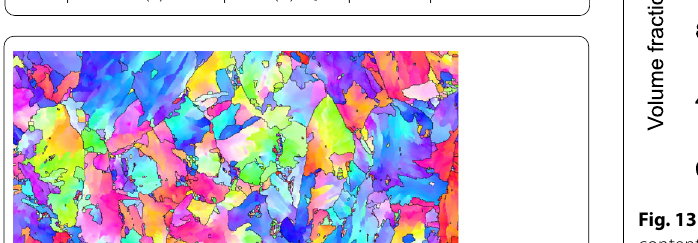
Fig. 10 EBSD result subjected to Final LePera etching conditions of 4Nb specimen. ( a ) IPF map and ( b ) IQ map of 4Nb specimen